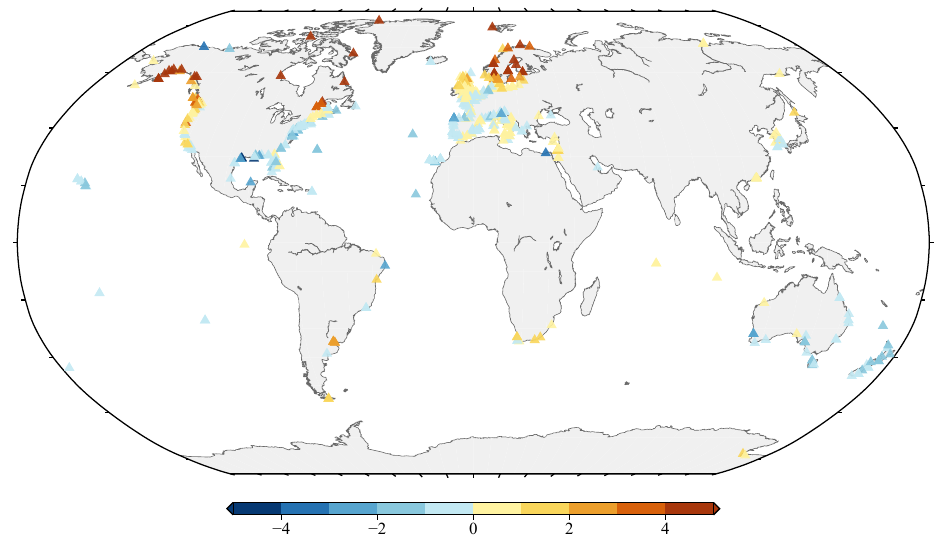
Figure 2. VLM (mmyr − 1 ) at TGs using the median of the neighboring trends.